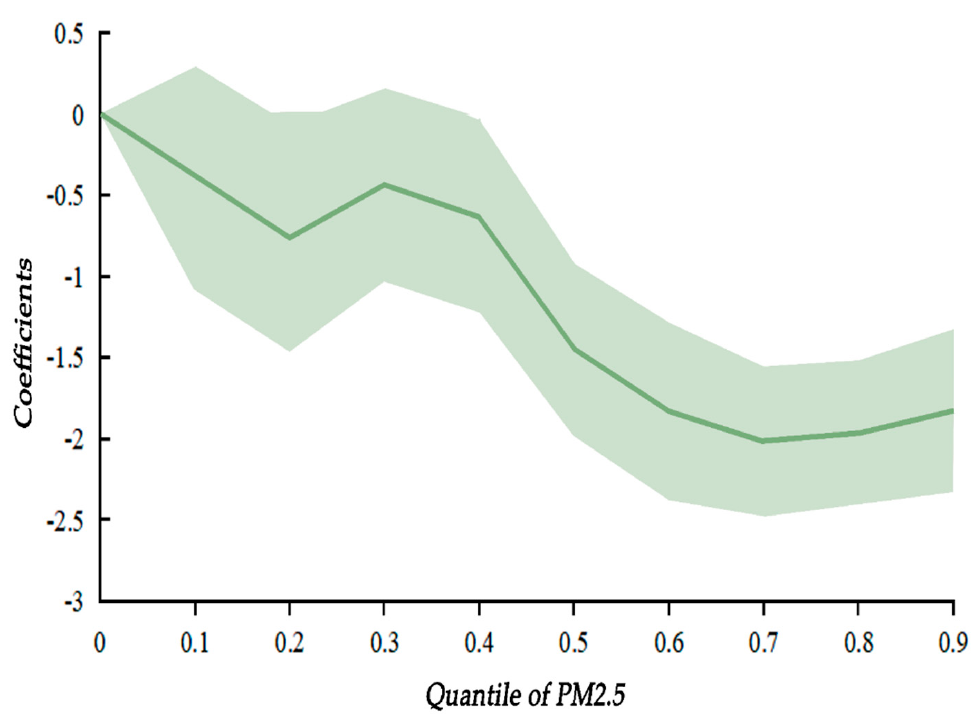
Figure 4. Variation trend of quantile regression coefficient of PM 2.5 . Table 8. Analysis of the regional heterogeneity of digitalization on PM 2.5 emissions.